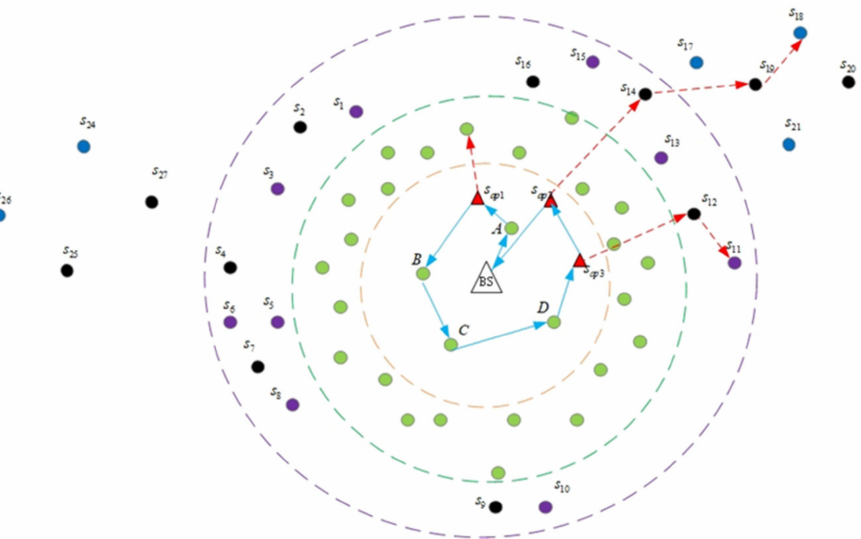
Figure 7. Scheduling for drones based on three cases of the target sensor locations.